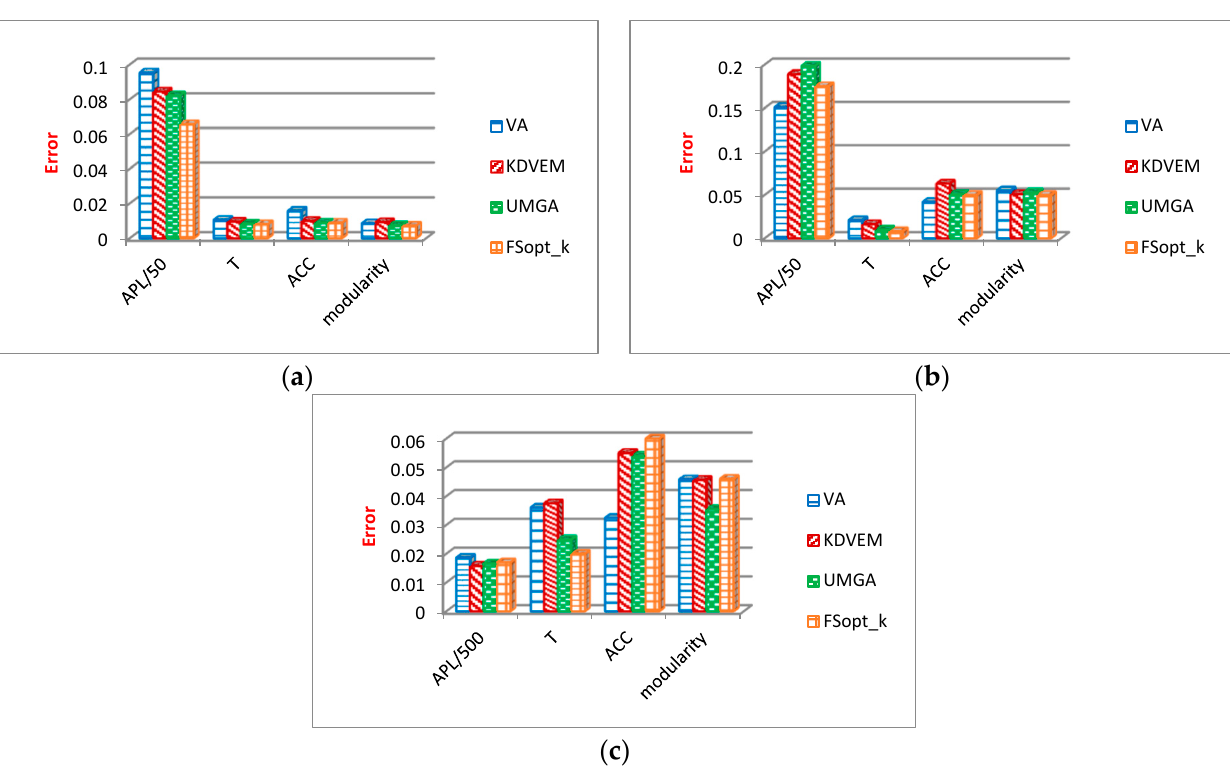
Figure 10. Comparison of error values of the algorithms on power grid dataset for ( a ): L = 0.05, ( b ): L = 0.1, and ( c ): L = 0.2.